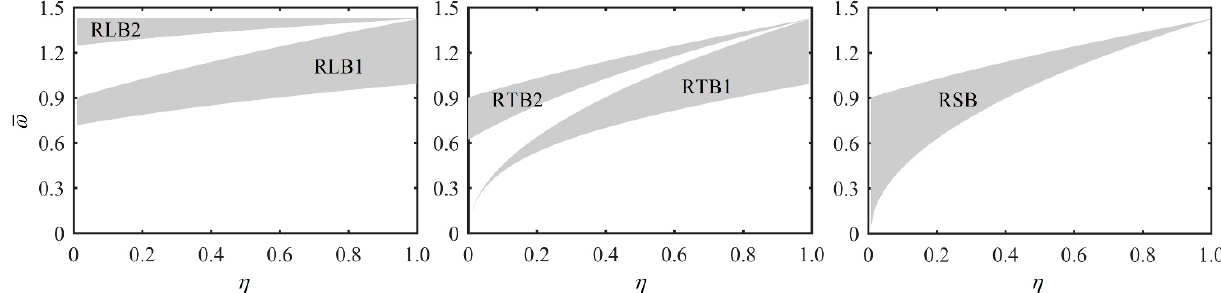
Figure 5. Variation of frequency bandgaps with stiffness ratio η : longitudinal waves ( left ), transverse waves ( middle ), and in-plane shear waves ( right ).